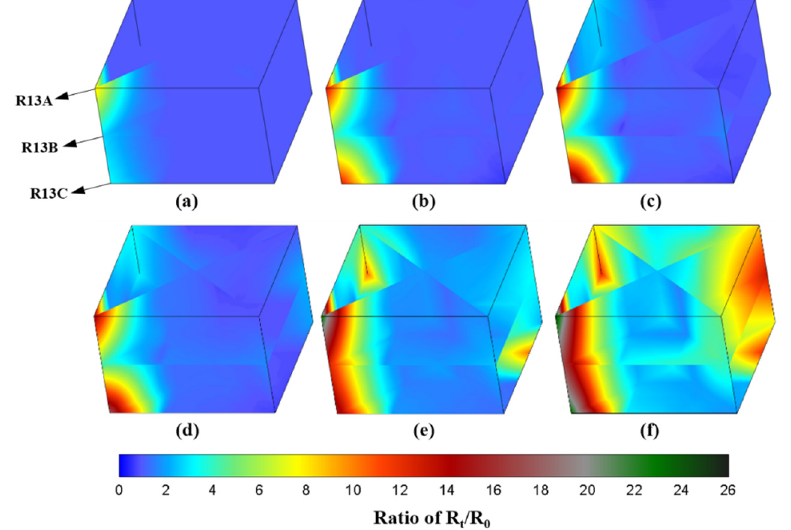
Figure 12. Space distributions of electric resistances in the simulated marine sediment from the starting point to the end point of methane seeping. ( a ) 3.3 h, ( b ) 20 h, ( c ) 41.7 h, ( d ) 83.3 h, ( e ) 120 h, ( f ) 146.7